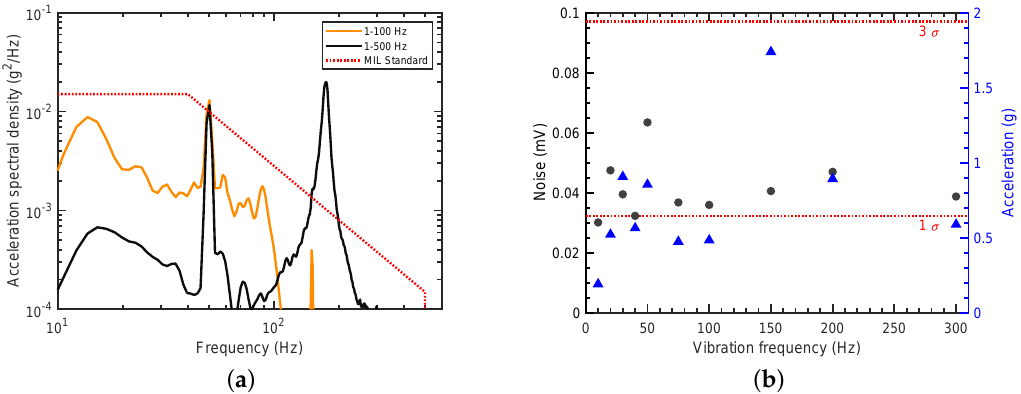
Figure 8. Vibration analysis: ( a ) Broadband acceleration spectral densities applied to the measurement setup during operation (yellow and black curves). Military standard vibration schedule for highway truck vertical vibration exposure (MIL-STD-810H, Method 514.8C-I [28]; red dotted line). ( b ) Measured signal noise (black circles) at the applied sinusoidal vertical peak accelerations (blue triangles) for zero air. Horizontal dotted lines mark 1 σ and 3 σ noise levels.